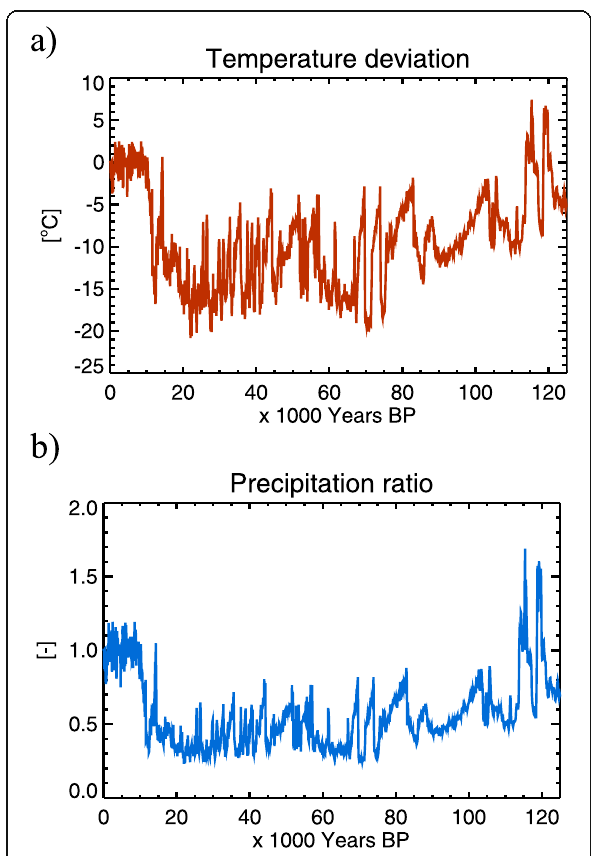
Fig. 2 125-k time series of the baseline driving forces for temperature and precipitation. The SeaRISE time series from the GRIP ice core are provided in terms of a temperature deviation and b precipitation ratio relative to the present-day values (set as